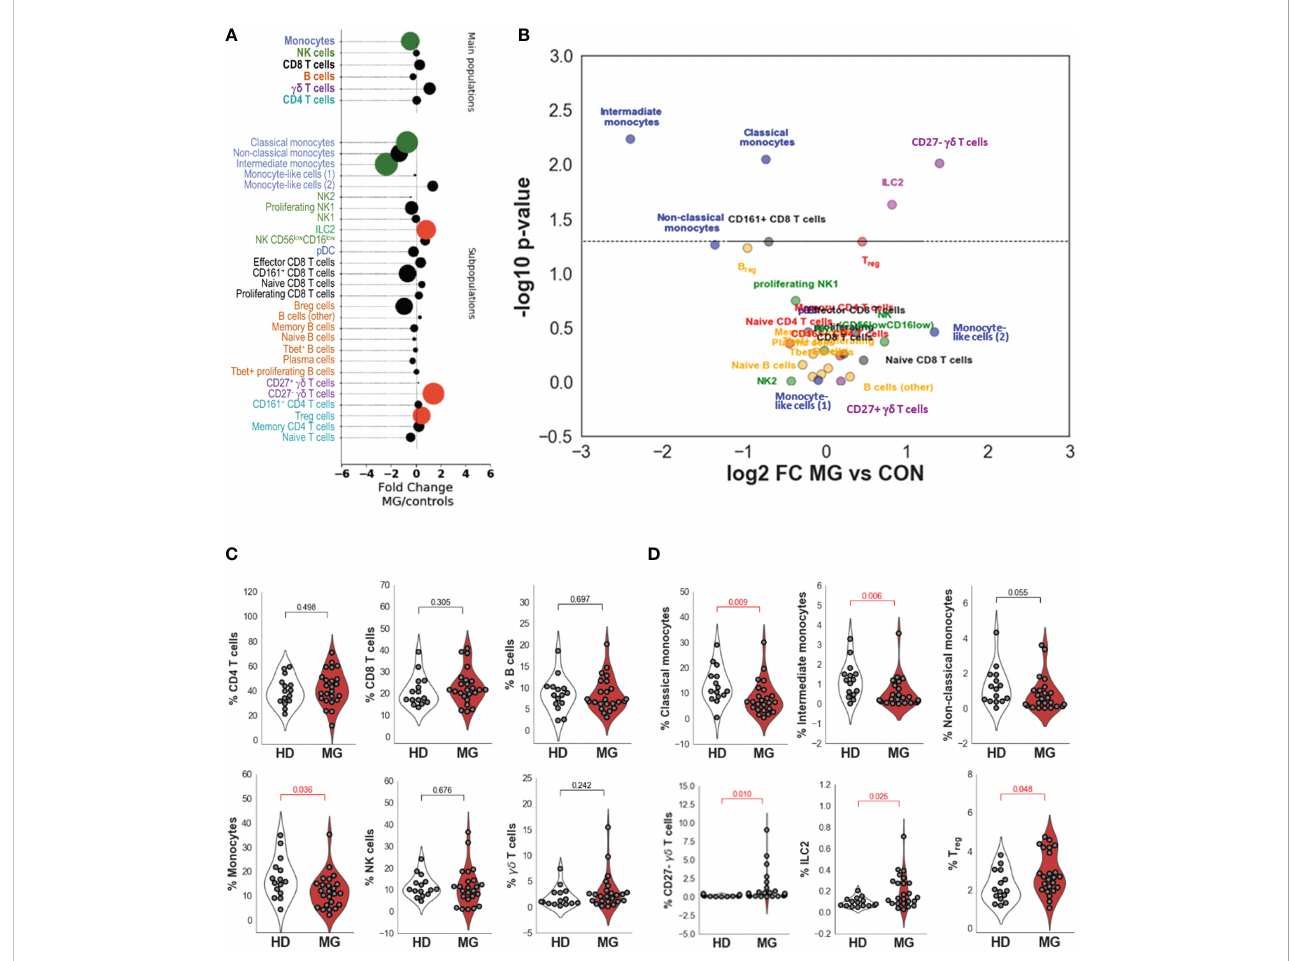
FIGURE 3 Differences between controls and MG patients. Bubble charts indicating log-2 median fold change of cell percentages between MG patients and controls for main cell populations and subpopulations. Bubble size is proportional to statistical signi fi cance and colorized in black if the difference is not signi fi cant, in green if the fold change is signi fi cantly lower in MG patients than in controls and in red if the fold change is signi fi cantly higher in MG patients than in controls (A) . Volcano plot indicating -log10 p values on the y-axis and log2 fold change between MG patients and healthy controls on the x-axis for the different annotated subpopulations (B) . Distribution of cell population percentages and differences between healthy donors (HD) and MG patients (MG) for the main cell populations (CD4, CD8, and gd T cells, B cells, NK cells, and monocytes) (C) and signi fi cant differences observed for cell subpopulations (Classical, intermediate and non-classical monocytes, CD27 - gd T cells, ILC2 and Treg cells) (D) . p values were determined by the Mann-Whitney test (two-tailed) for non-parametric